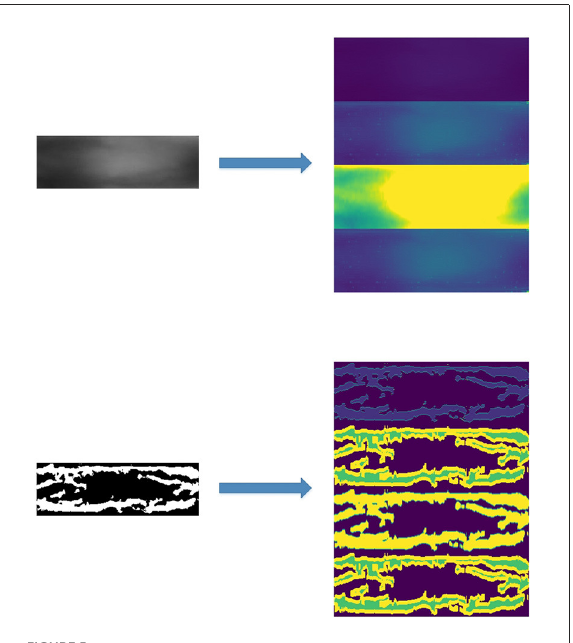
binary image. Figure 3 illustrates the segmentation image from a gray-scale image.